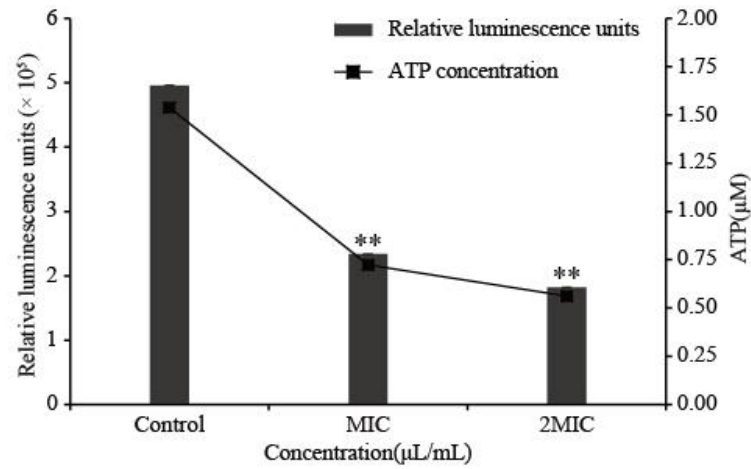
Figure 5. Intracellular ATP content of C. sakazakii treated with LC-EO (** p < 0.01).